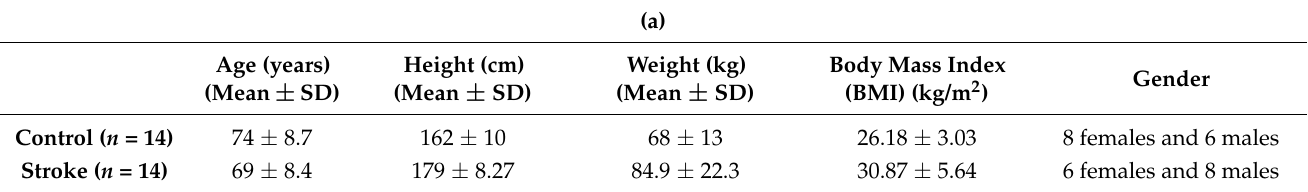
Table 1. ( a ) Anthropometric data of stroke participants and healthy older adults. ( b ) Turning variable and its definitions.